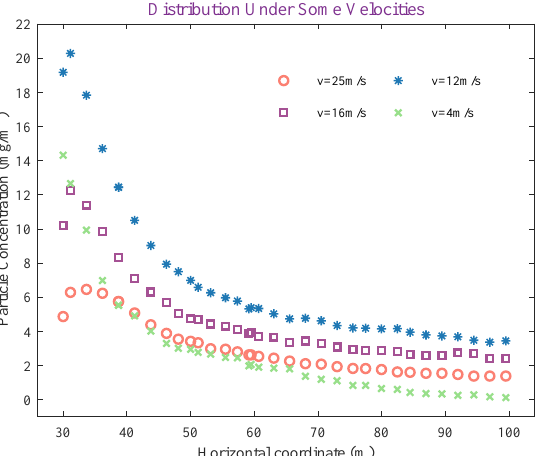
Figure 7. Variation of dust concentration with distance (4 m/s, 12 m/s, 16 m/s, and 25 m/s).